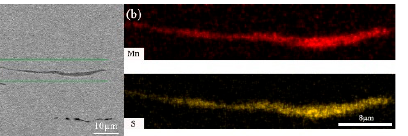
Figure 9. Typical diagrams of pure MnS inclusions ( a ) SEM morphology of inclusions; ( b ) composition distribution of inclusions.